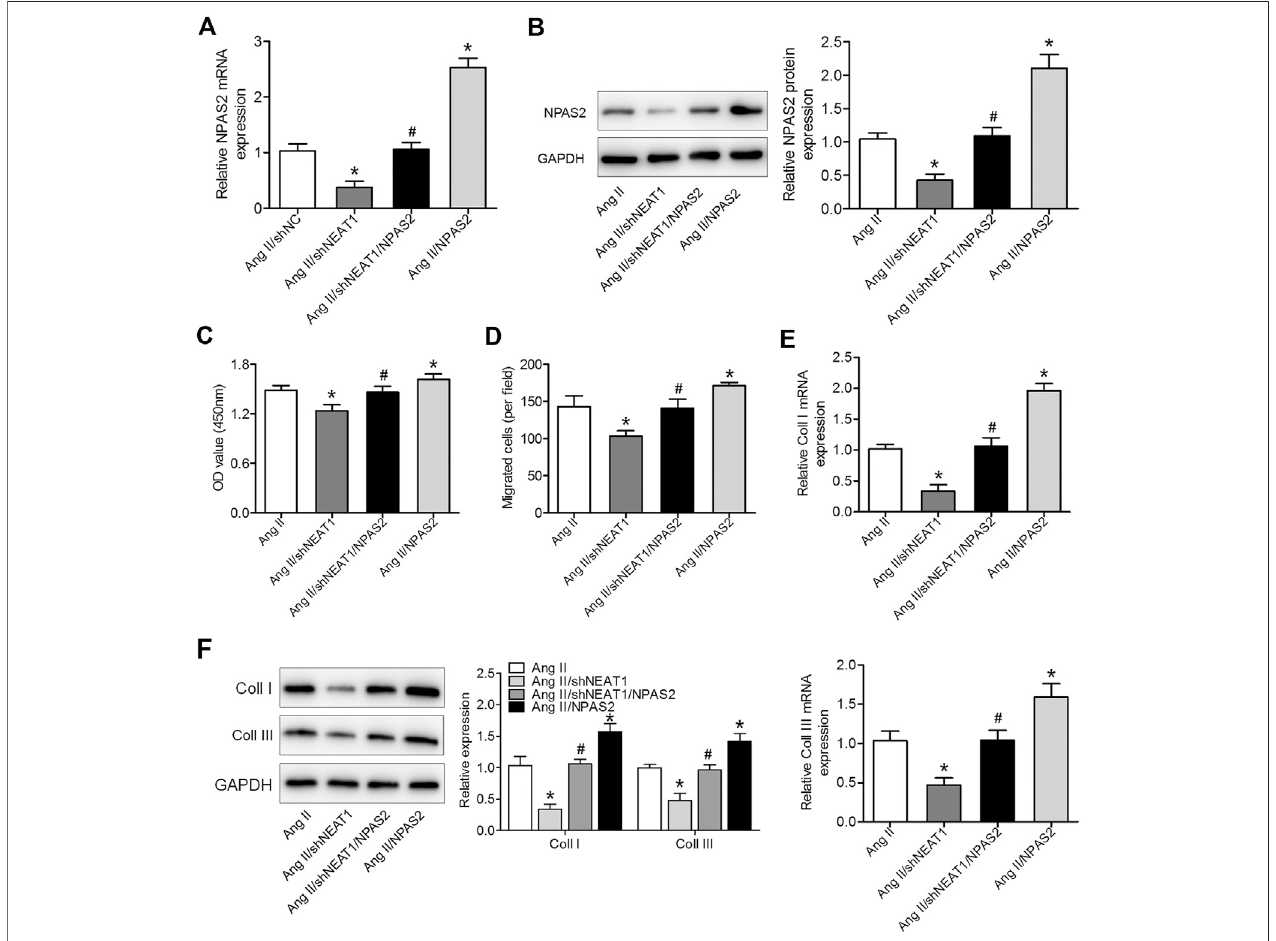
FIGURE 4 | NPAS2 overexpression reversed the effect of NEAT1 knockdown on cardiac fi broblast proliferation, migration, and collagen production under Ang II condition. (A,B) mRNAandproteinexpressionsofNPAS2incardiac fi broblaststransfectedwithshNEAT1orNPAS2orco-transfectedwithshNEAT1andNPAS2under Ang II induction were detected. (C) Cell proliferation and (D) migration were determined in different groups. (E,F) mRNA and protein expressions of coll I and coll III in differentgroupsweredetermined.* p < 0.05vs.AngIIgroup; # p < 0.05vs.AngII/shNEAT1group.Datarepresentmean ± SDfromthreeindependentexperiments.